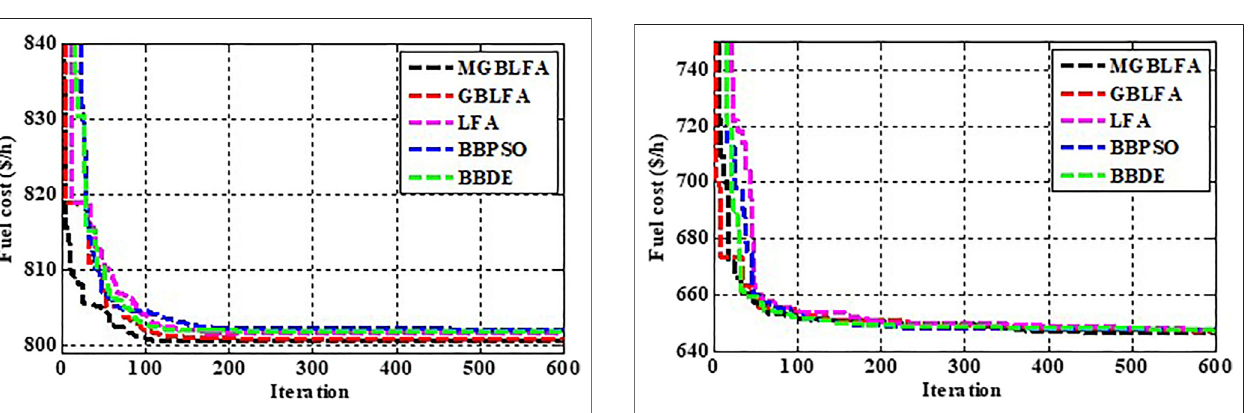
FIGURE 3 | Convergence characteristics of the algorithms for case